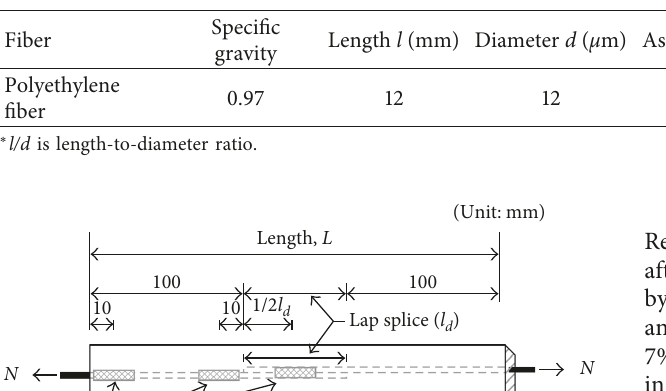
Table 2: Mechanical properties of polyethylene (PE) fiber.